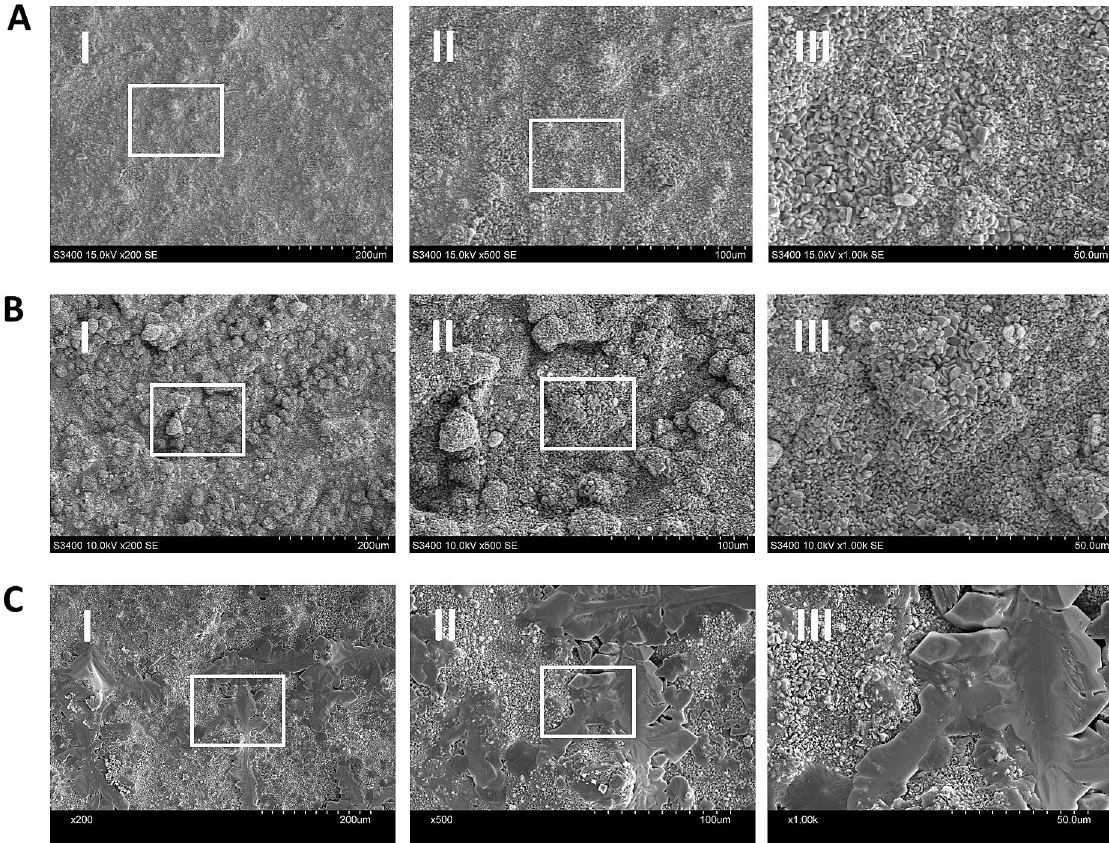
Figure 2. Scanning electron microscopy analysis of WMTA discs immersed in NaOCl. SEM micrographs obtained from Cont-WMTA ( A ), D-WMTA ( B ), and Na-WMTA ( C ). Original magnification: ×200 (I), ×500 (II), and ×1000 (III). White boxes in (I) and (II) indicate magnified